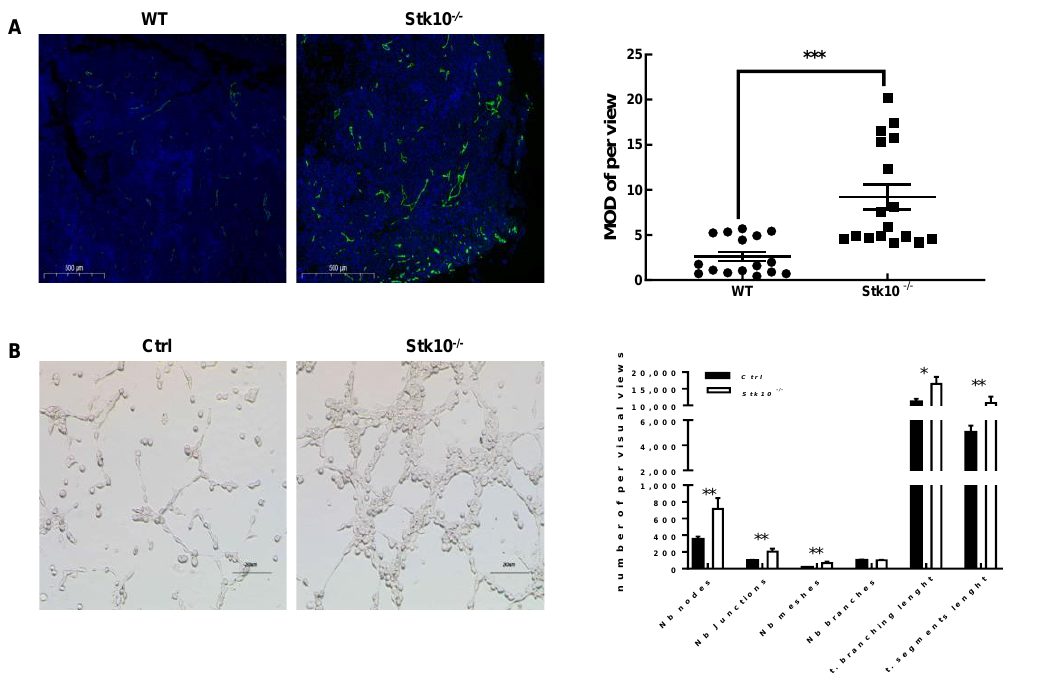
Figure 7. Stk10 deficiency led to abundant tumor angiogenesis. ( A ) CD31 expression on blood vessels in the RM-1 tumor tissues from WT and Stk10 − / − mice ( n = 3/group). Scale bars: 500 µ m. The average optical density of CD31 staining was measured with Image J Pro Plus 6.0 software (Media Cybernetics, Inc.). MOD: mean optical density. ( B ) Deletion of Stk10 in RM-1cells inhibited angiogenic properties in HUVEC cells in vitro. The tubes were photographed under a microscope at 10 × magnification. The tube nodes, branches, junction numbers and length were measured using the Image J software (version 1.8.0.112) The data are presented as relative means compared with control treatment. Data are presented as mean ± SEM of at least three independent experiments. * p < 0.05; ** p < 0.01; *** p < 0.001.